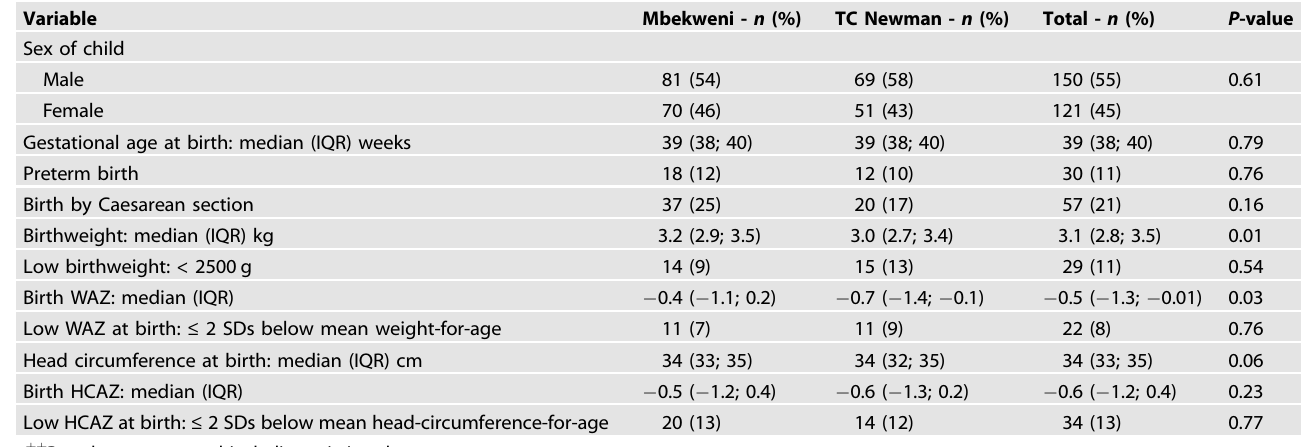
Table 2. Anthropometry at birth ++